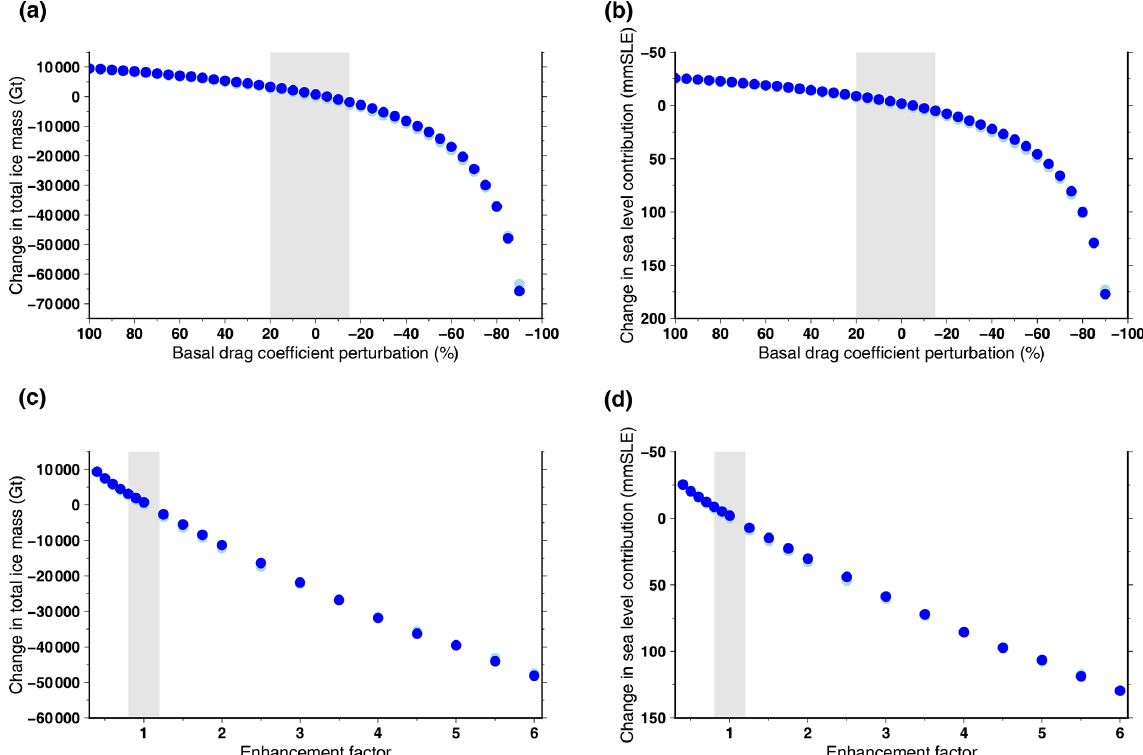
Figure 11. Change in ice volume for a modification of the basal-drag coefficient (a, b) and different values of the enhancement factor (c, d) . In this figure, each dot represents the difference in 2100 with respect to the standard experiment (no basal-drag-coefficient perturbation and enhancement factor at 1). The dark-blue dots are projection experiments that use MIROC5 under RCP8.5 with a medium oceanic sensitivity. The light-blue dots are control experiments ctrl_proj . Some control experiments can be hidden by the projection experiments if they imply a similar volume change. The perturbations are applied starting in the year 2045. The vertical grey band stands for the range of perturbations that produce 0.1% of total mass change in the perturbed control experiment with respect to the standard control experiment. The difference is expressed in total ice mass (a, c) and ice volume contributing to sea level rise (b, d)